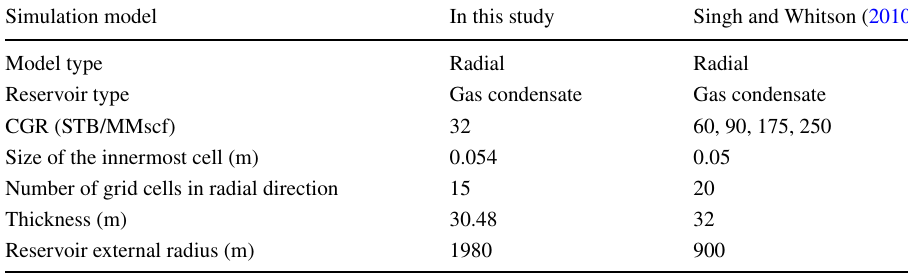
Table 3 Model parameters comparison between in this study and in Singh and Whitson (2010)